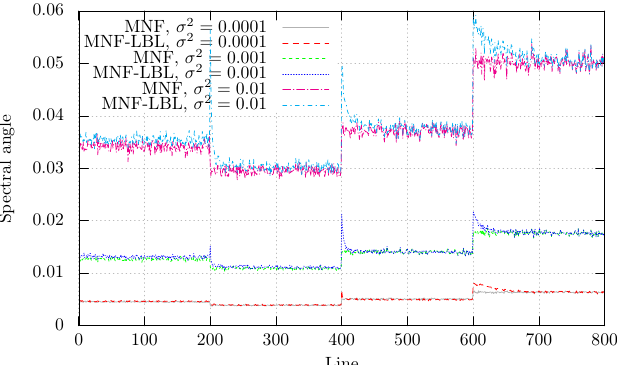
Figure 4. Difference between denoised and simulated